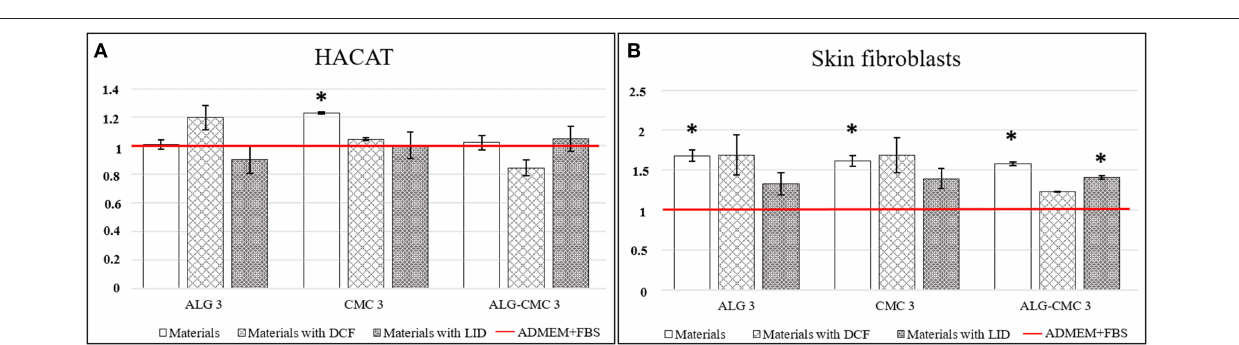
FIGURE 7 | (A) HaCaT cells’ viability determination using the MTT assay for all samples and the control; ADMEM + FBS (red line in graph), (B) Skin Fibroblast cells’ viability determination using the MTT assay for all samples and the control; ADMEM + FBS (red line in graph). Error bars represent standard deviation of the replicate measurements. Statistical significance is defined as * P < 0.05 (ANOVA test) for all samples compared to the